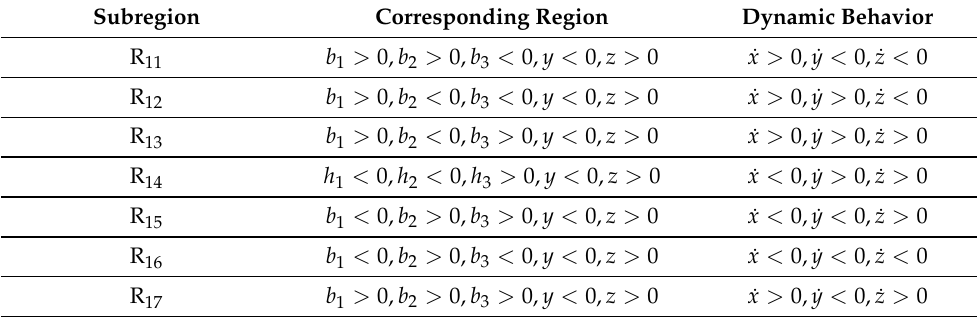
Table 2. Dynamic behavior of the trajectories in the seven subregions. Subregion Corresponding Region Dynamic